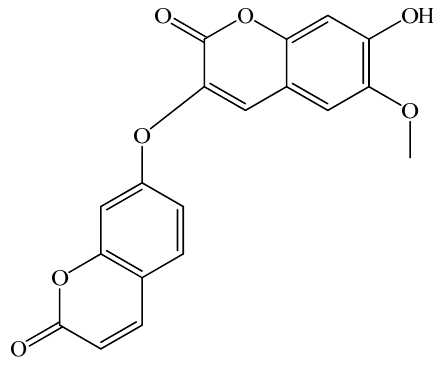
Figure 1. Chemical structure of